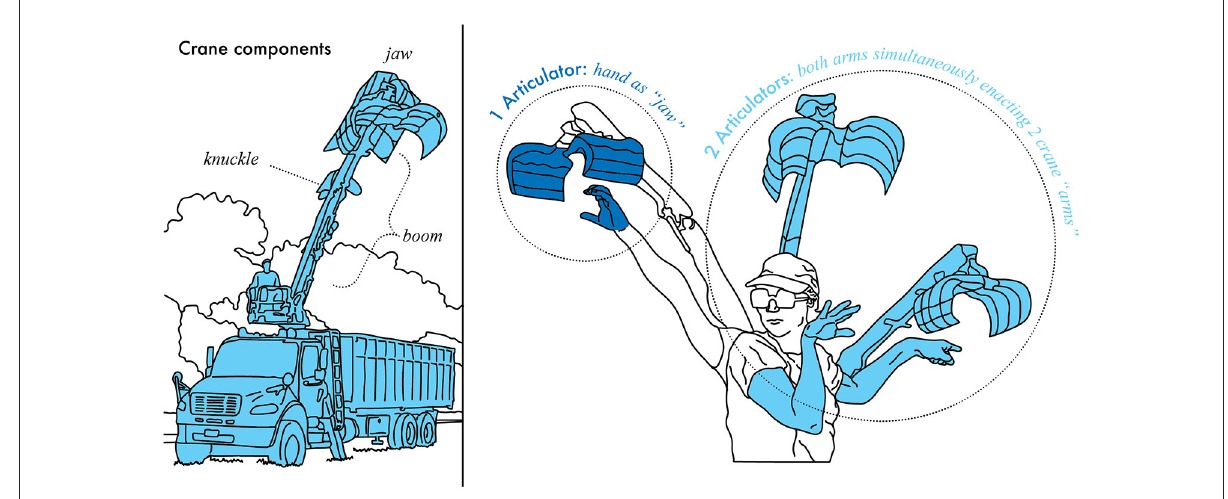
FIGURE1 Marking of brush